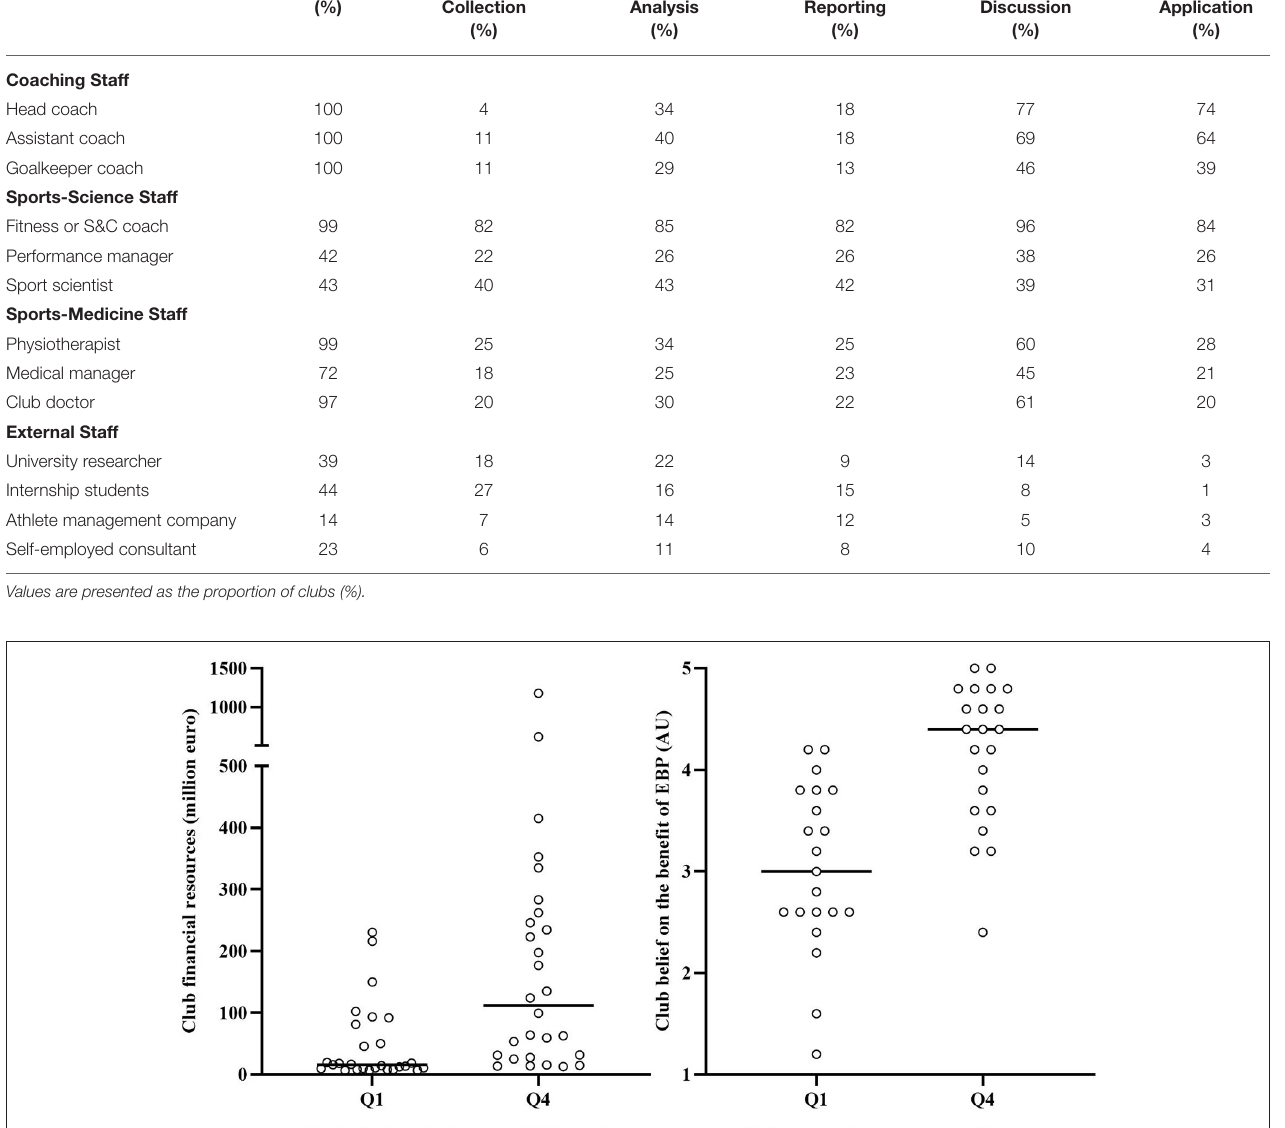
Presence Involvement if present (%) Collection Analysis Reporting Discussion Application (%) (%) (%) (%)